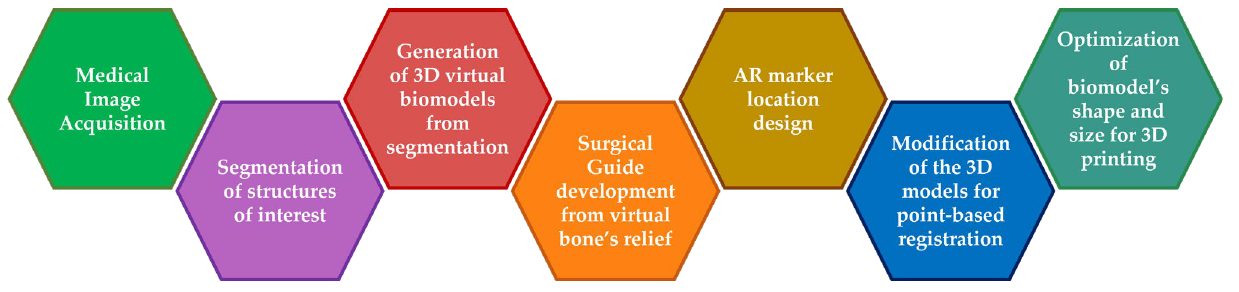
Figure 1. Diagram of the workflow presented in [21] to develop a patient phantom and a surgical guide.